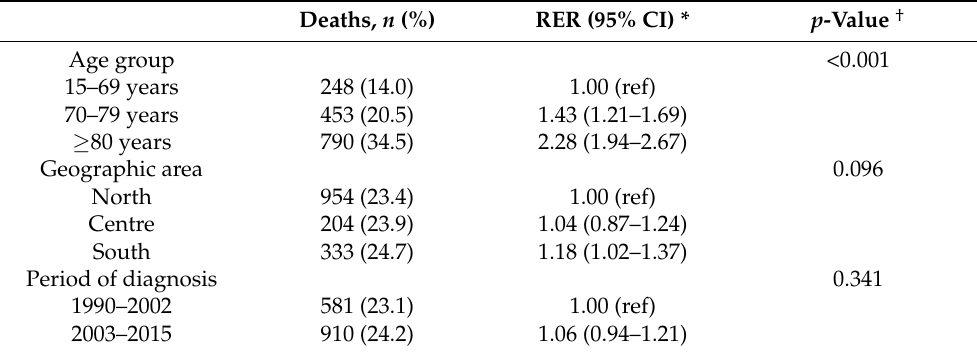
Table 6. Multivariate relative excess risk (RER) of death from vulvar squamous cell carcinoma at